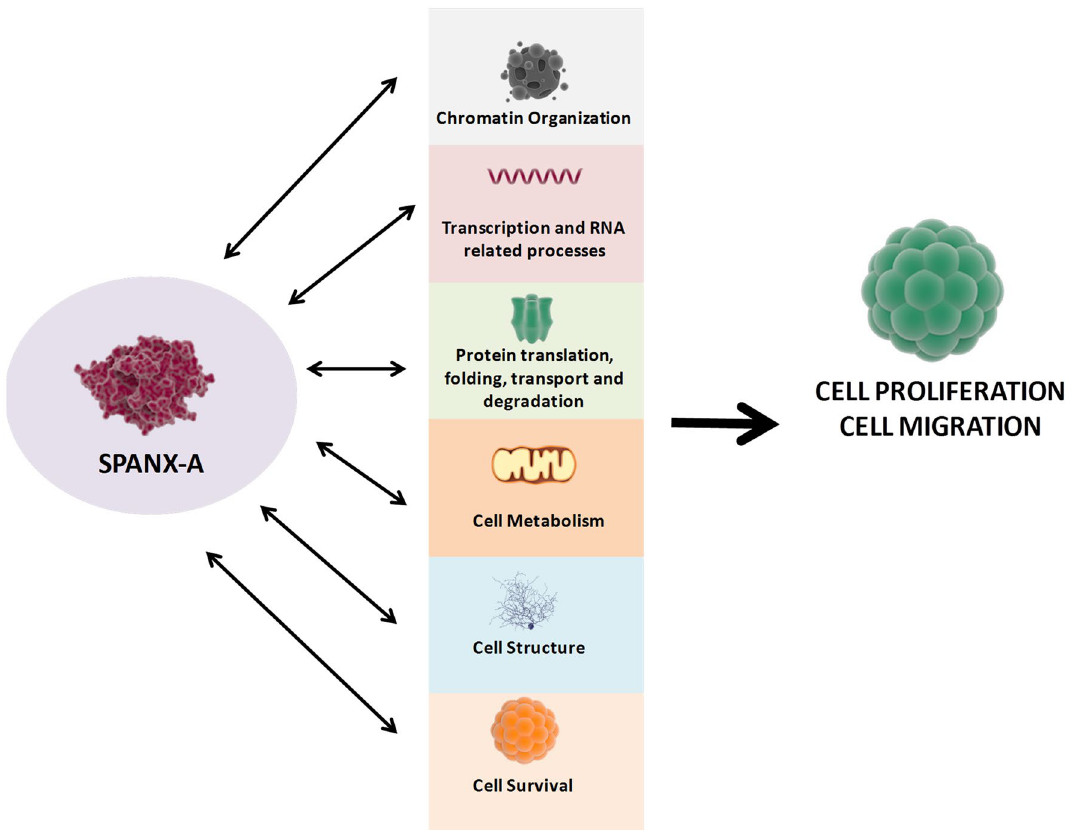
Figure 4. Role of SPANX-A in human melanoma. Representative scheme of the multifunctional role of SPANX-A in tumor progression. SPANX-A it is mainly involved in multifunctional processes like chromatin organisation, transcription and RNA related processes, protein translation initiation, protein folding, transport and degradation, cell metabolism and structure, which promote cell proliferation, motility and migration of cancer in human